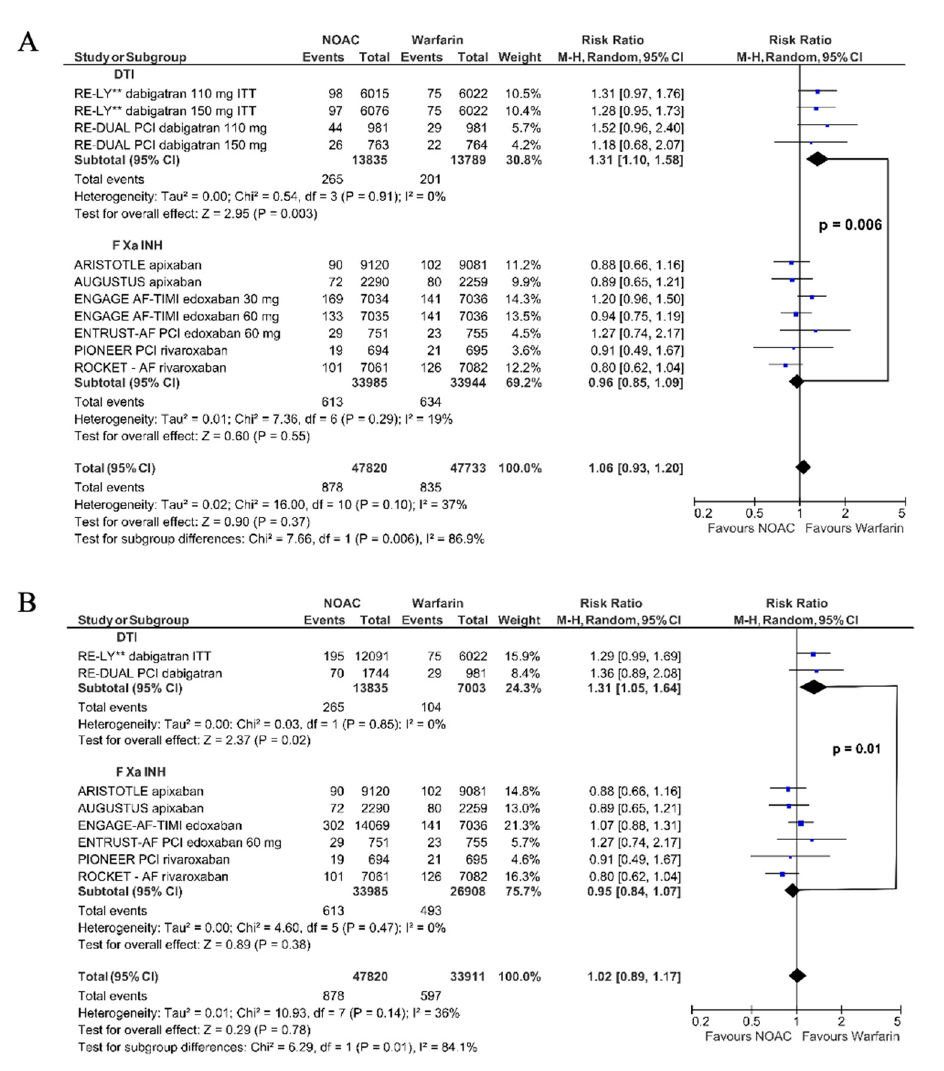
p interaction : dabigatran vs. FXa inhibitors p = 0.02 (Supplementary Figure S26A).